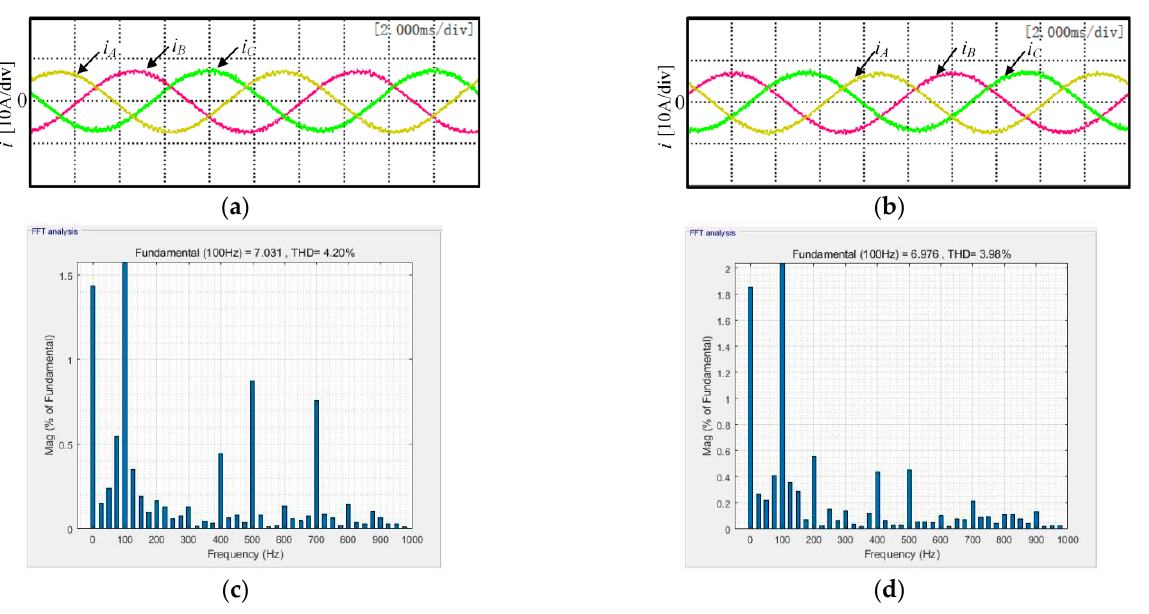
Figure 12. Comparison of three-phase current waveforms and THD: ( a ) the three-phase current waveform of the conventional deadbeat direct power control; ( b ) the three-phase current waveform of the proposed scheme; ( c ) THD of conventional deadbeat direct power control current; ( d ) THD of proposed scheme current.